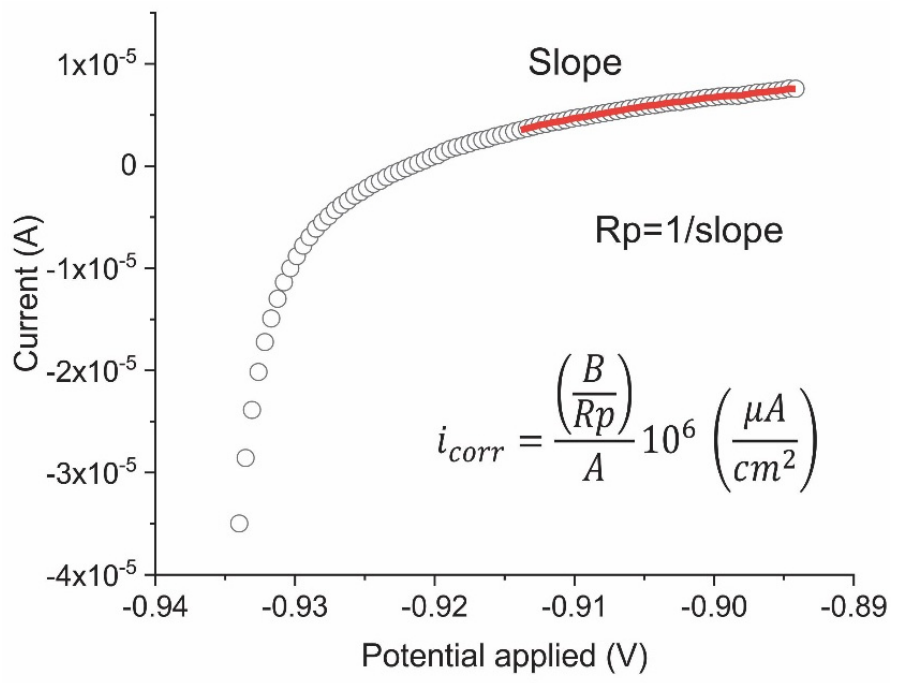
Figure 3. Example of the LPR test and Rp